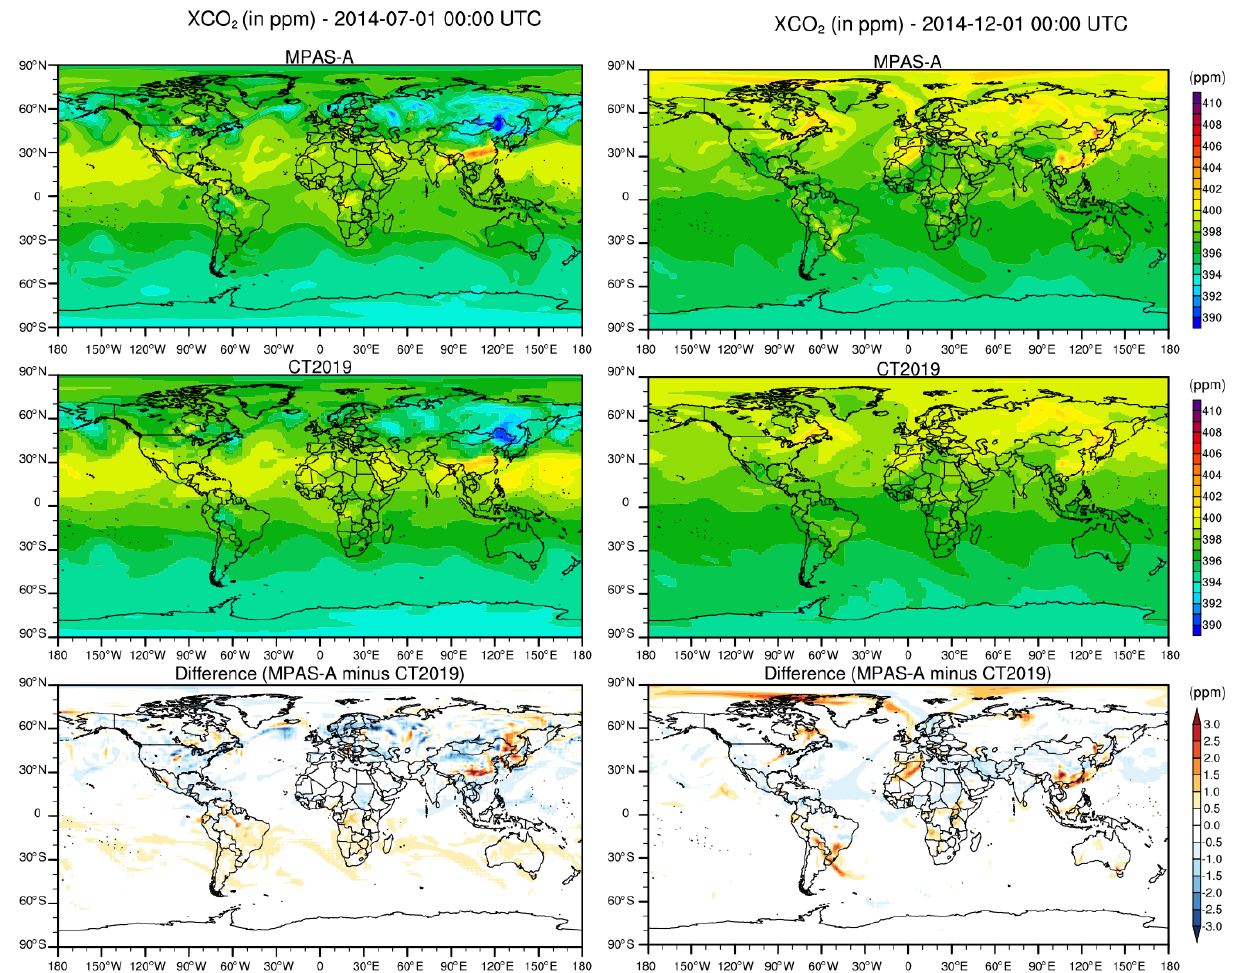
Figure 4. Simulated XCO 2 of MPAS-A, CT2019, and their difference on 1 July 2014 and 1 December 2014, 00:00 UTC.